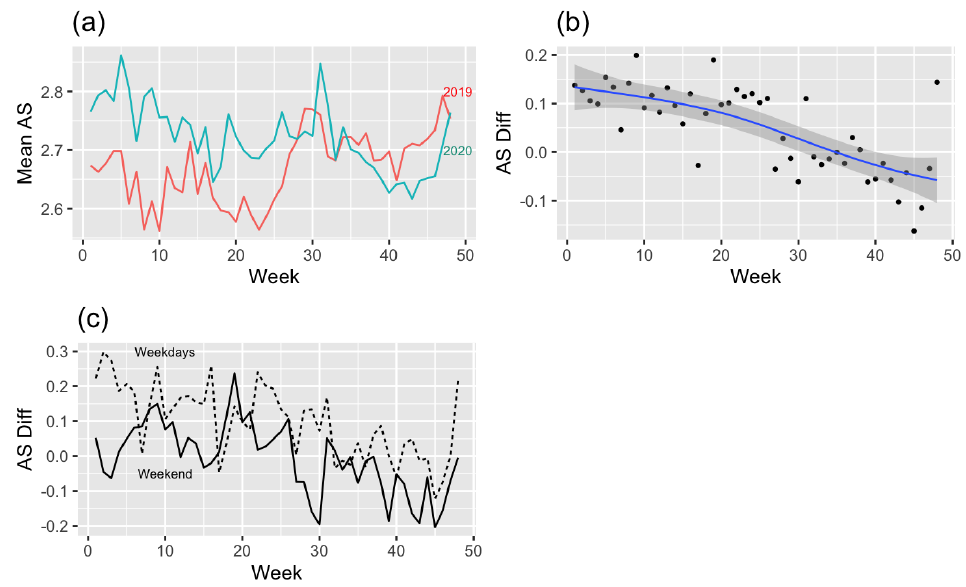
Figure 5. ( a ) Mean average speed (2019–2020) by week, ( b ) regression model (linear mixed model) graph of average speed difference (2019–2020), and ( c ) difference in the average speed of weekdays or weekends